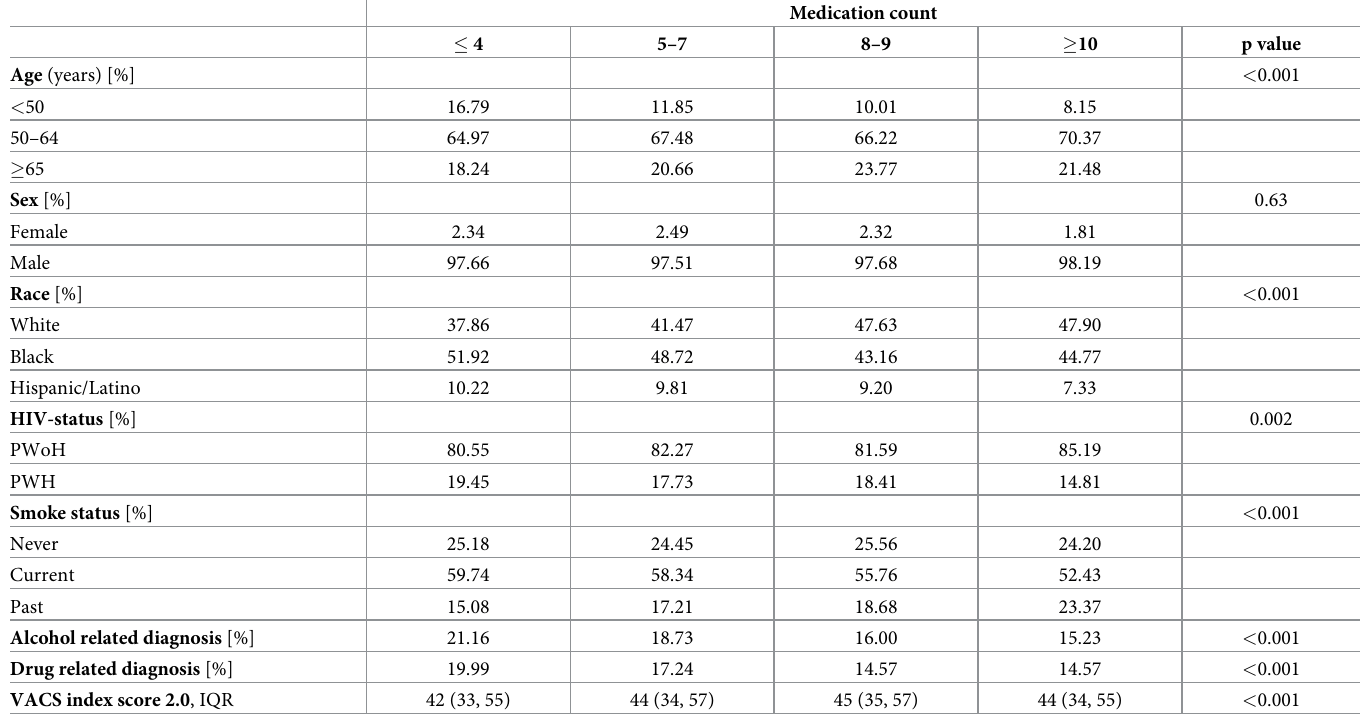
Table 2. Descriptive statistics of patient’s baseline characteristics by polypharmacy